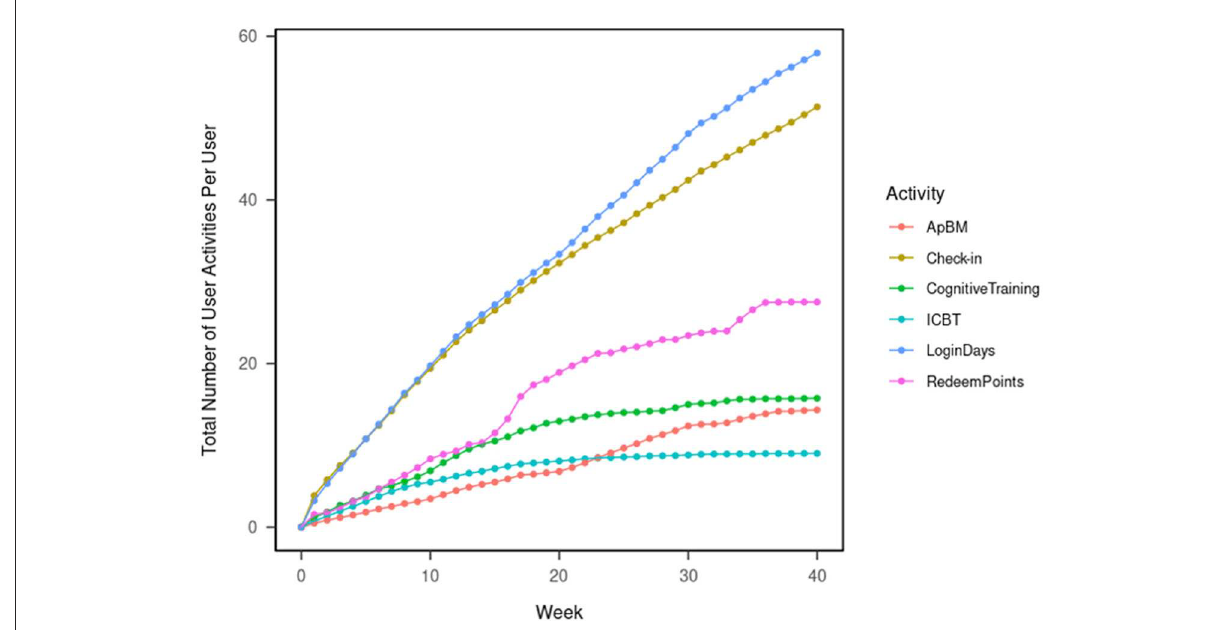
FIGURE1 User activities in the DTx application.